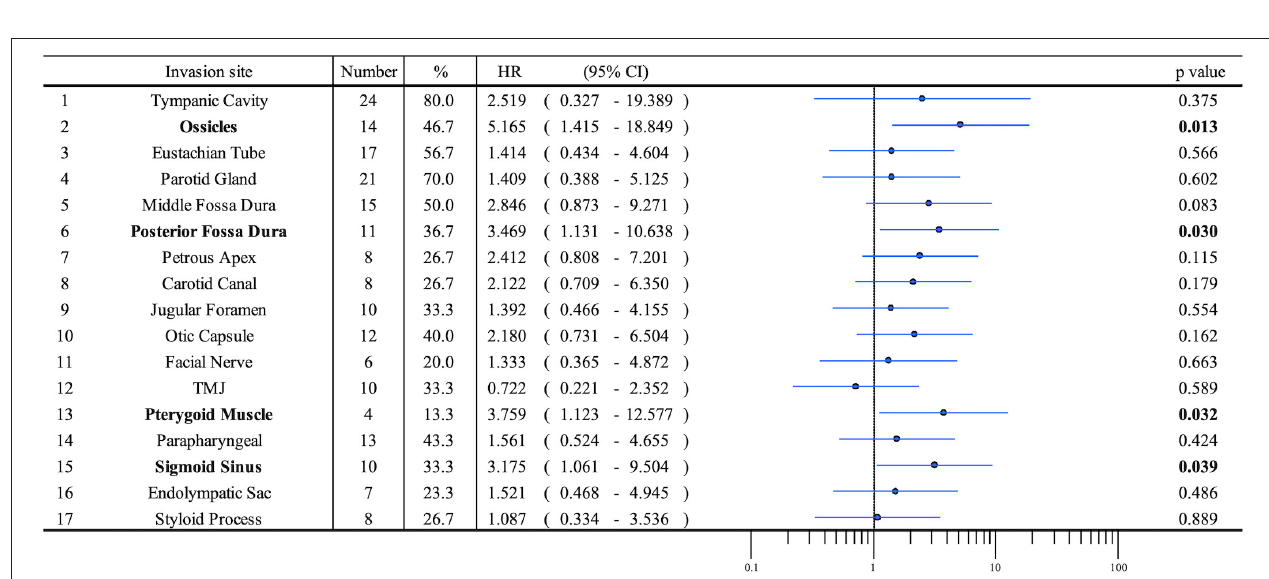
FIGURE 3 | Anatomical factors predicting survival (univariate analysis) using a forest plot.